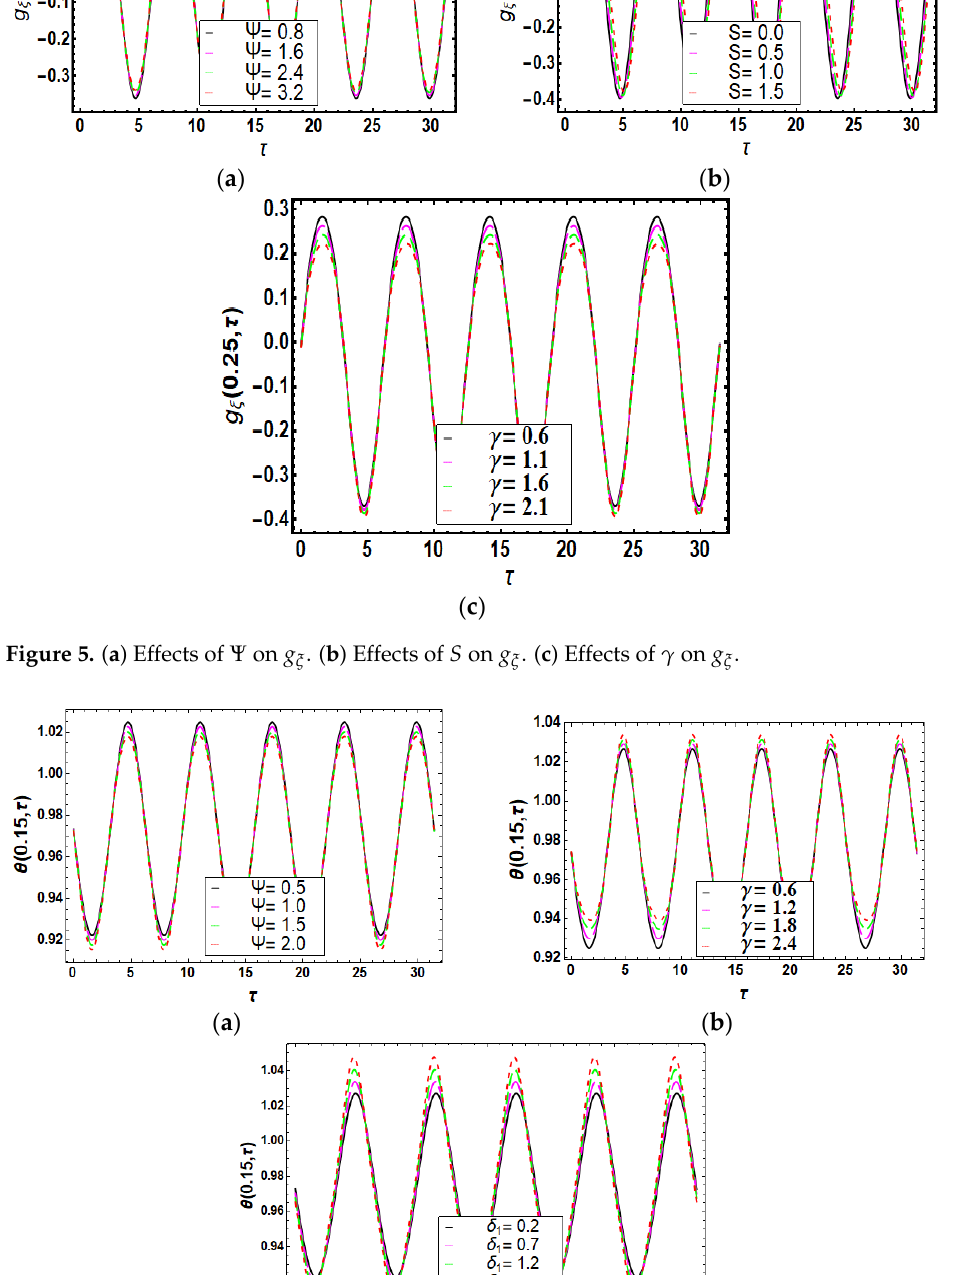
Ψ θ on . ( b ) E ff ects of